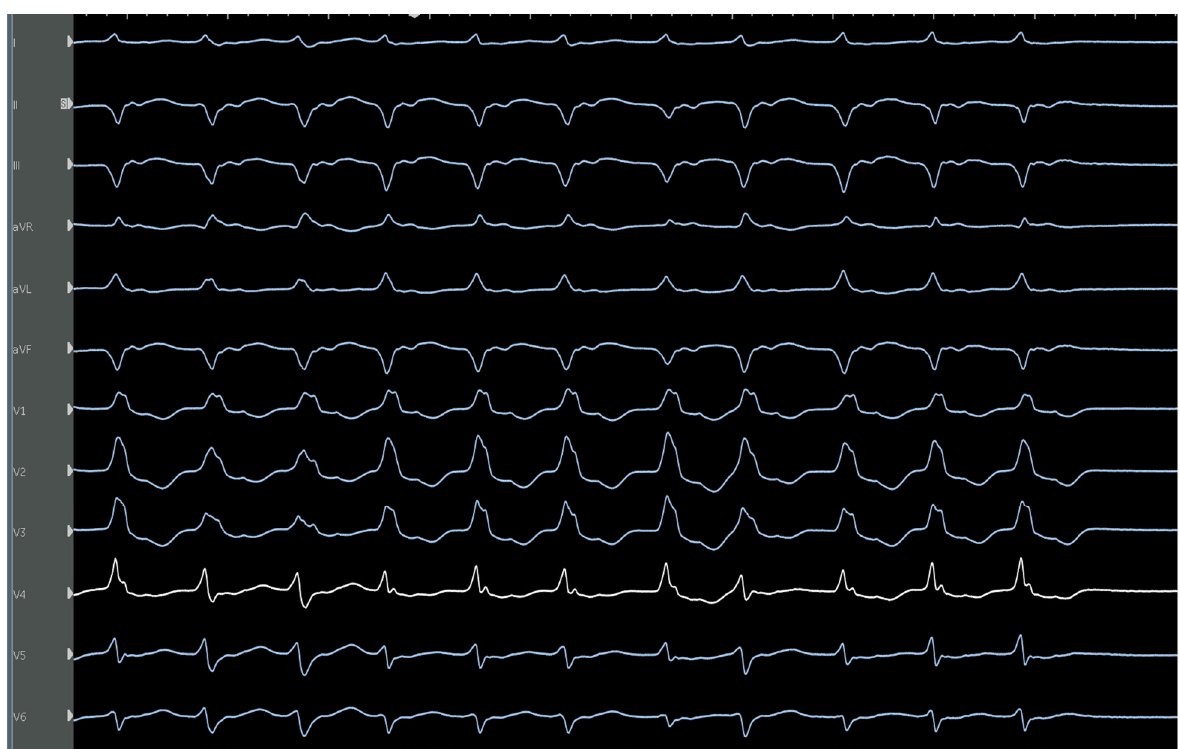
Figure 13. Characteristic ECG of posteromedial papillary muscle VT with a RBBB, left superior axis, and later precordial transition to R/S configuration.